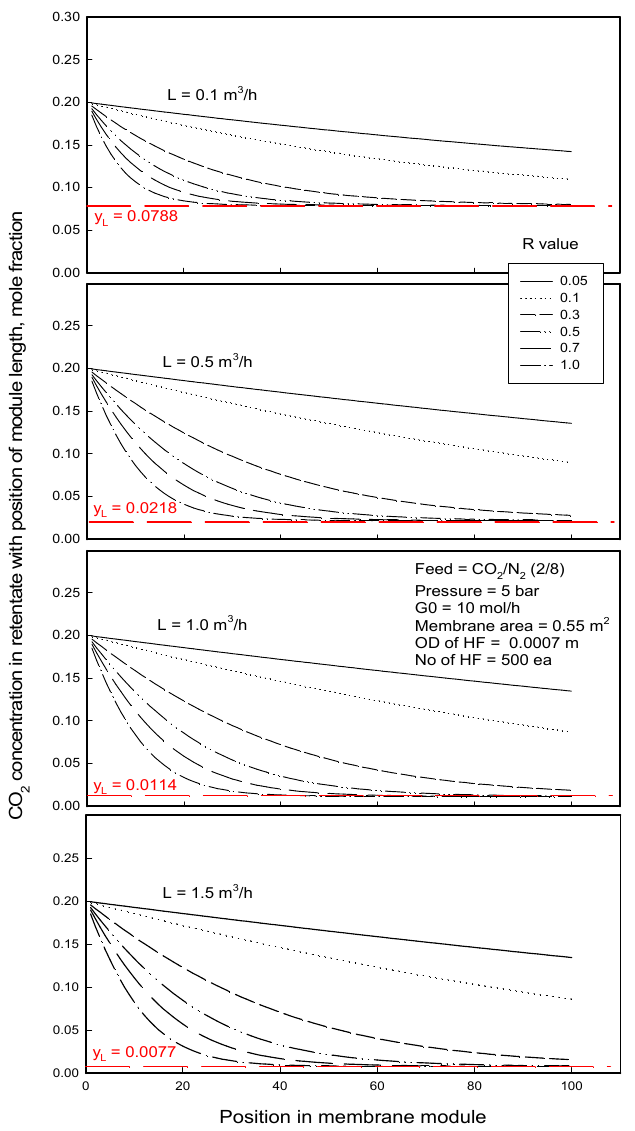
Figure 13. CO 2 concentration in feed flow module with position of porous polypropylene membrane in membrane contactor separation of CO 2 /N 2 mixture, and y L = CO 2 concentration in feed stream adjacent to the interface, in equilibrium with the saturated concentration of CO 2 x iE in the liquid stream.